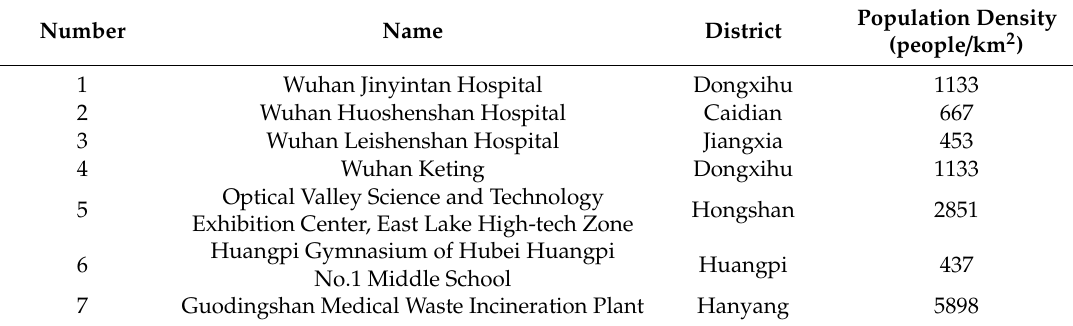
Table A4. Candidate locations for temporary treatment